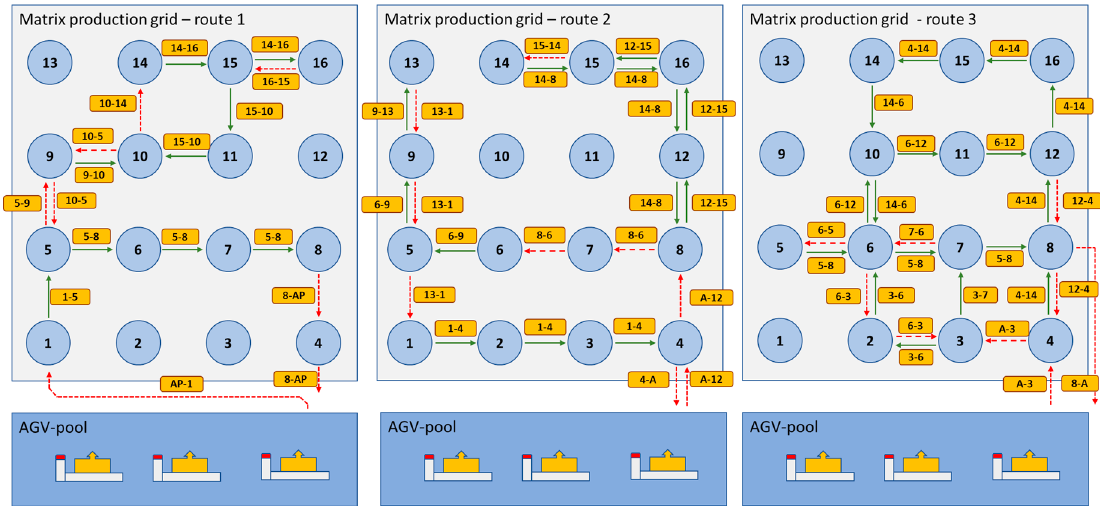
Figure 16. Results of extended clustering, assignment and routing of AGVs.